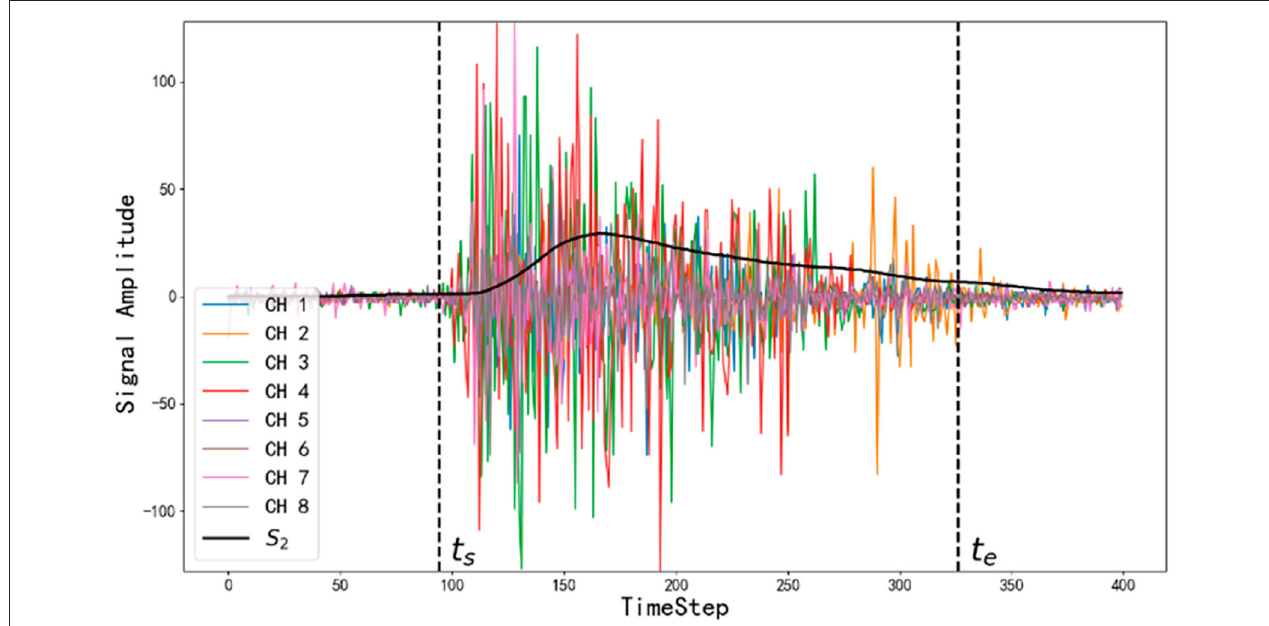
FIGURE 3 | The curves of surface electromyography (sEMG) and the motion detection result (Zhang et al.,